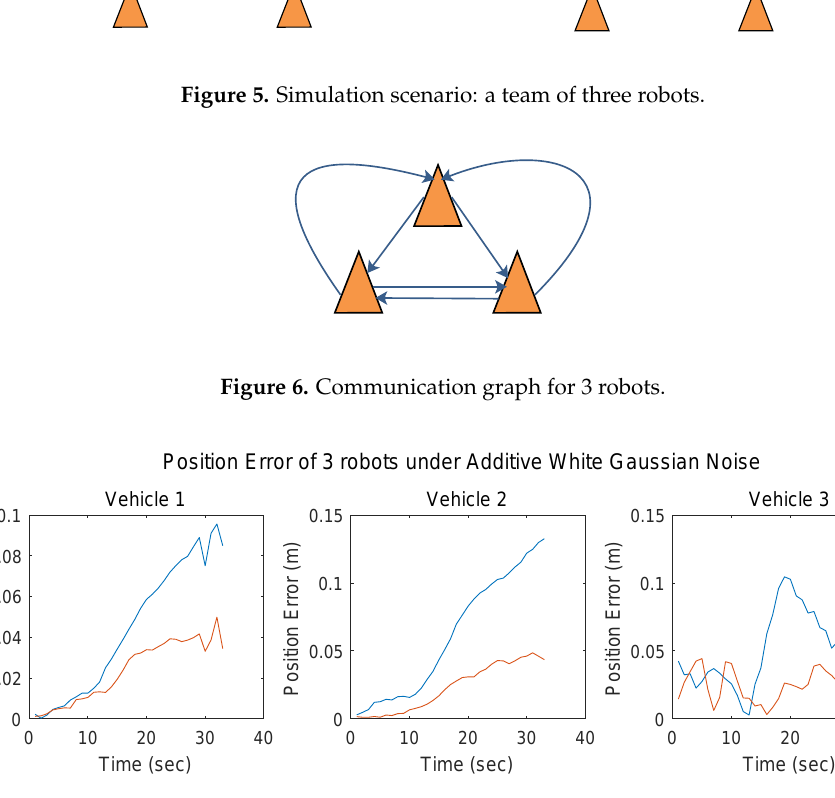
Figure 7. Position errors of 3 robots under additive white Gaussian noise.